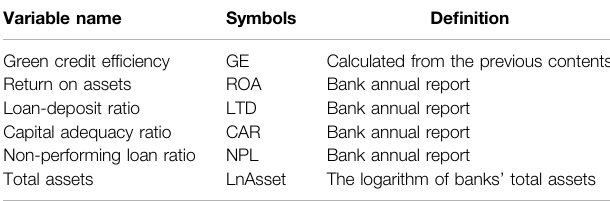
TABLE 3 | List of